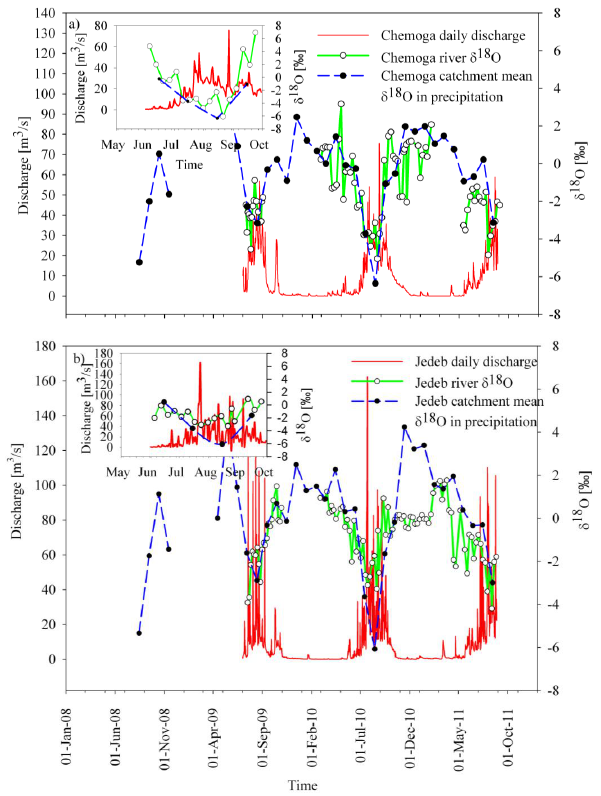
Figure 9. Temporal variations in δ 18 O and δ 2 H composition in pre- Fig. 9. Temporal variations of δ 18 O and δ 2 H composition in precipitation and river cipitation and river discharge along with the daily flow rate for discharge along with the daily flow rate for a) Chemoga catchment and b) Jedeb (a) the Chemoga catchment and (b) the Jedeb catchment. The in- catchment. The inset figures are the details for summer season discharge and isotopes set figures are the details for summer season discharge and isotope composition for precipitation and streamflow for the hydrological year 2010. composition for precipitation and streamflow for the hydrological year 2010.